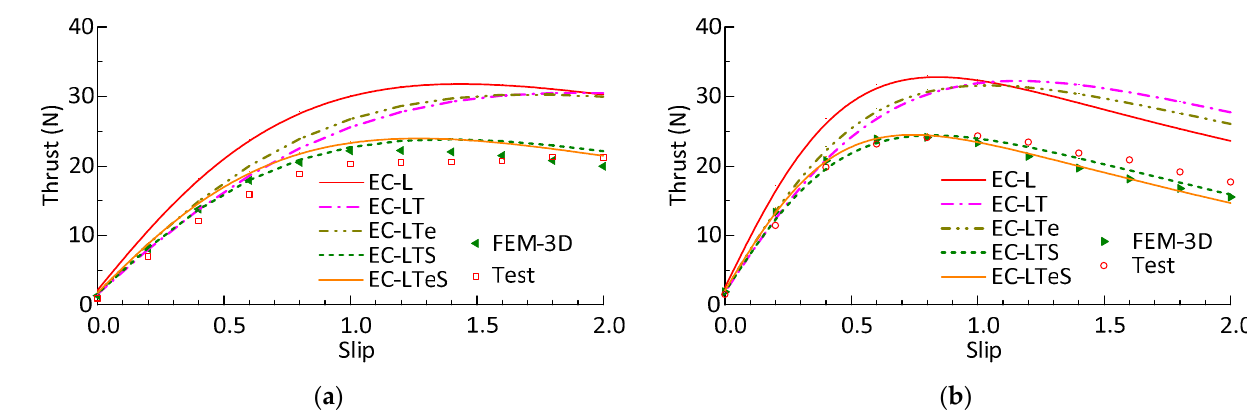
Figure 11. Calculation, simulation, and test results of thrust: ( a ) at 60 Hz; ( b ) at 110 Hz.